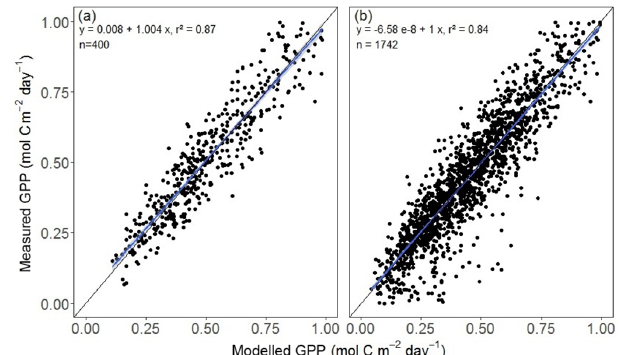
Figure 7. The measured GPP plotted as a function of the modelled GPP for two different datasets: (a) only the days before the first major O 3 peak in every year and (b) the training dataset with the days after the first major O 3 peak in every year, excluding those with high O 3 fluxes plus 6 following days to train the network. The black line is the 1:1 line. The blue line is the regression fit including 95% confidence intervals (in grey).